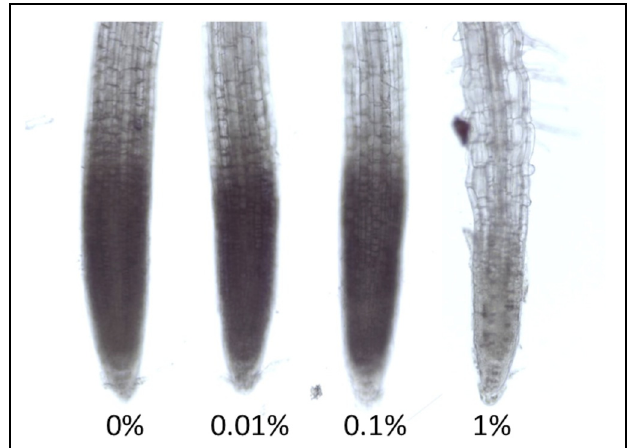
FIGURE 3 | Light Stereomicroscope pictures of NBT staining for superoxide detection. Seedlings were grown in different concentrations of MES for 6 days. These were incubated for 5 min in NBT. The representative picture is shown here ( n = 5).